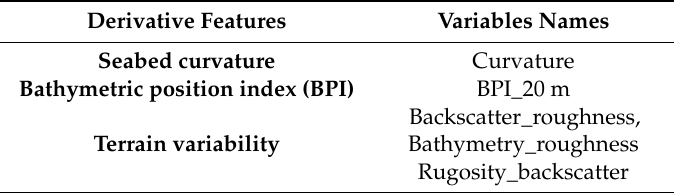
Table 1. Secondary acoustic features generated from bathymetry and